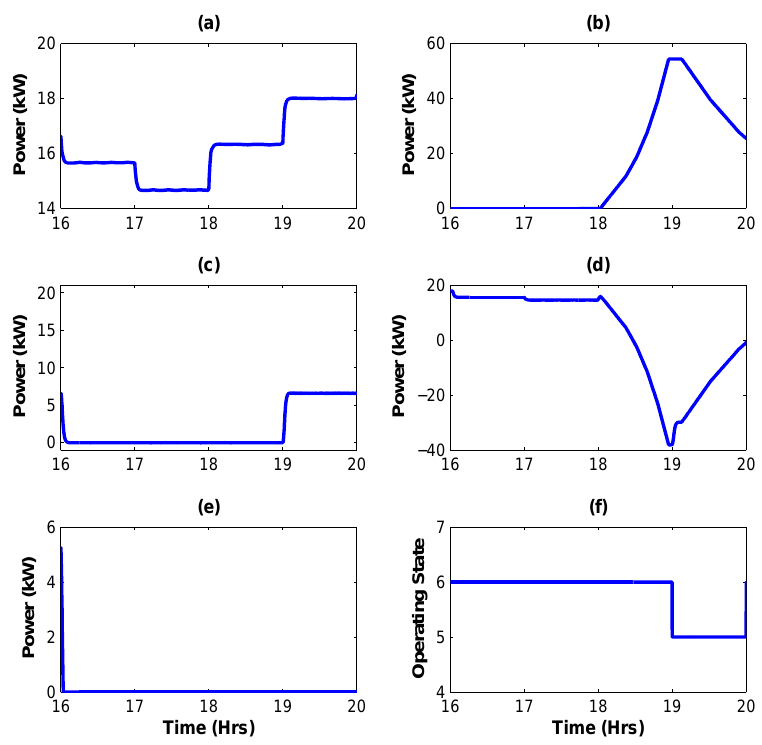
Figure 20. Simulation results for t = 16–20 h; ( a ) P DL , ( b ) P WT , ( c ) P CDi , ( d ) P NG , ( e ) P ES , ( f ) operating